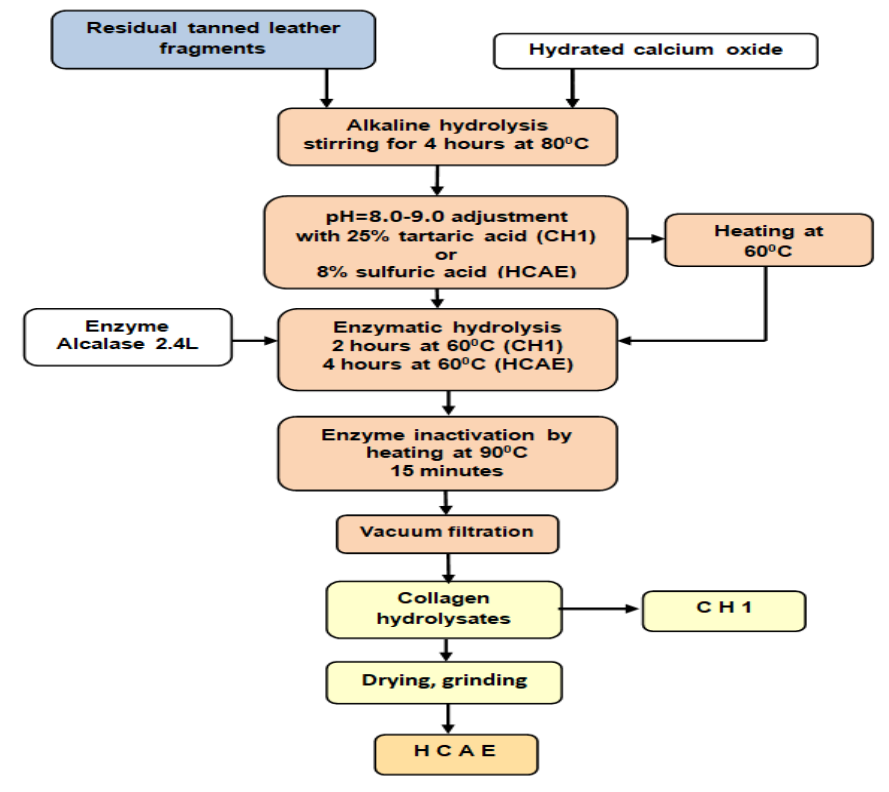
Figure 2. The flowchart of collagen hydrolysates preparation .